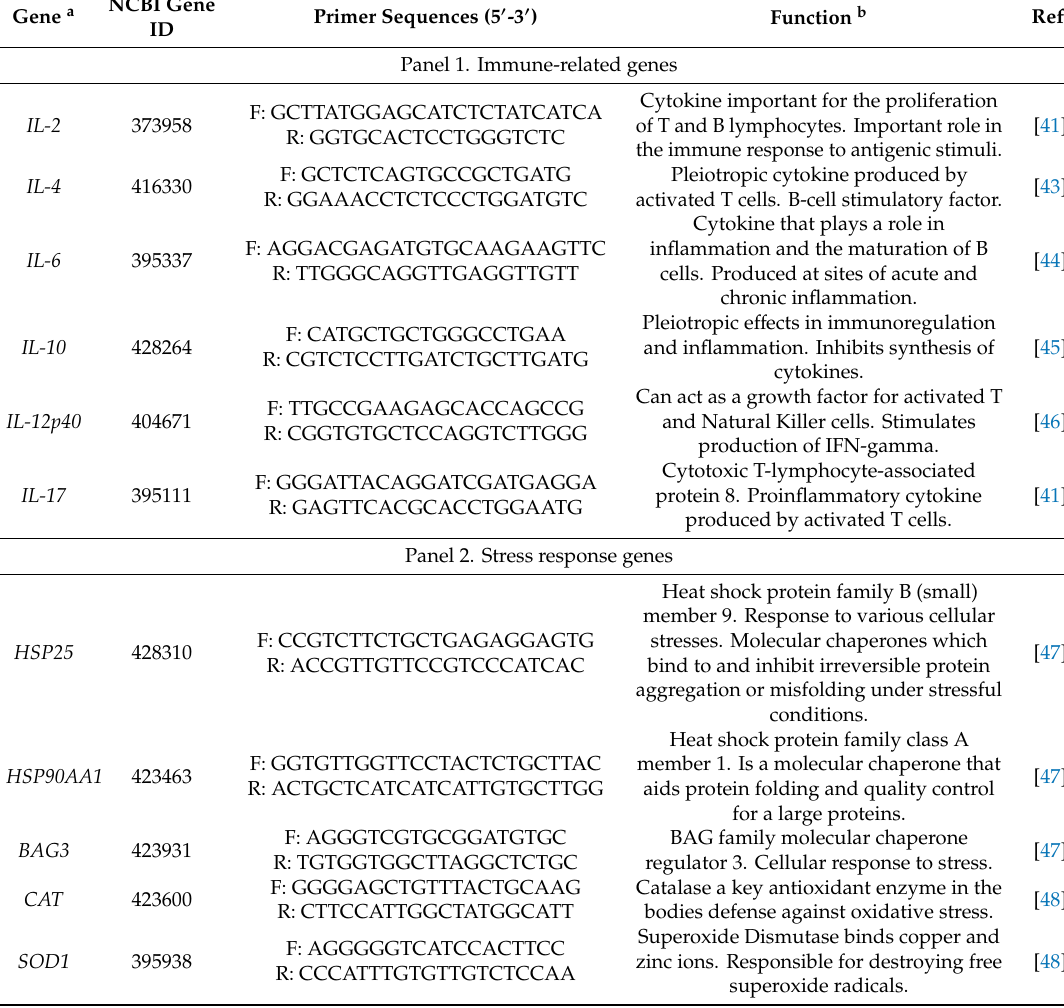
Table 2. List of target genes and primers sequences for